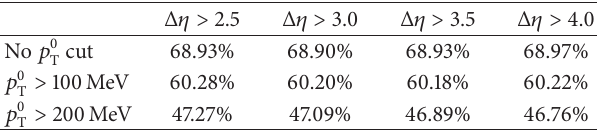
Table 9: The fraction of events without a primary vertex and with a primary vertex for the different number of charged particles, 𝑁 ch . Tracker region is considered as |𝜂| < 2.5 and 𝑝 T > 200MeV charged particles are used to form the vertex. Only the events that have